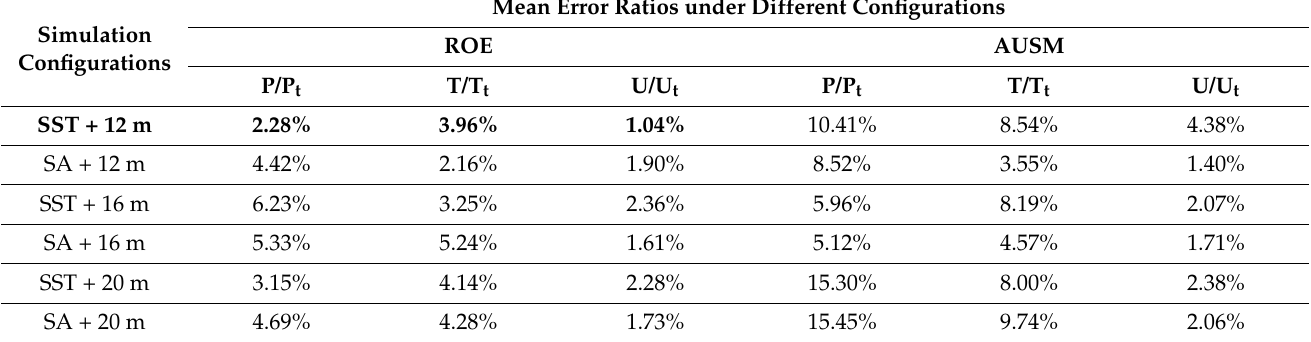
Table 13. The mean error ratios of P/P t , T/T t , and U/U t of the sharp trailing edge based on NACA4.